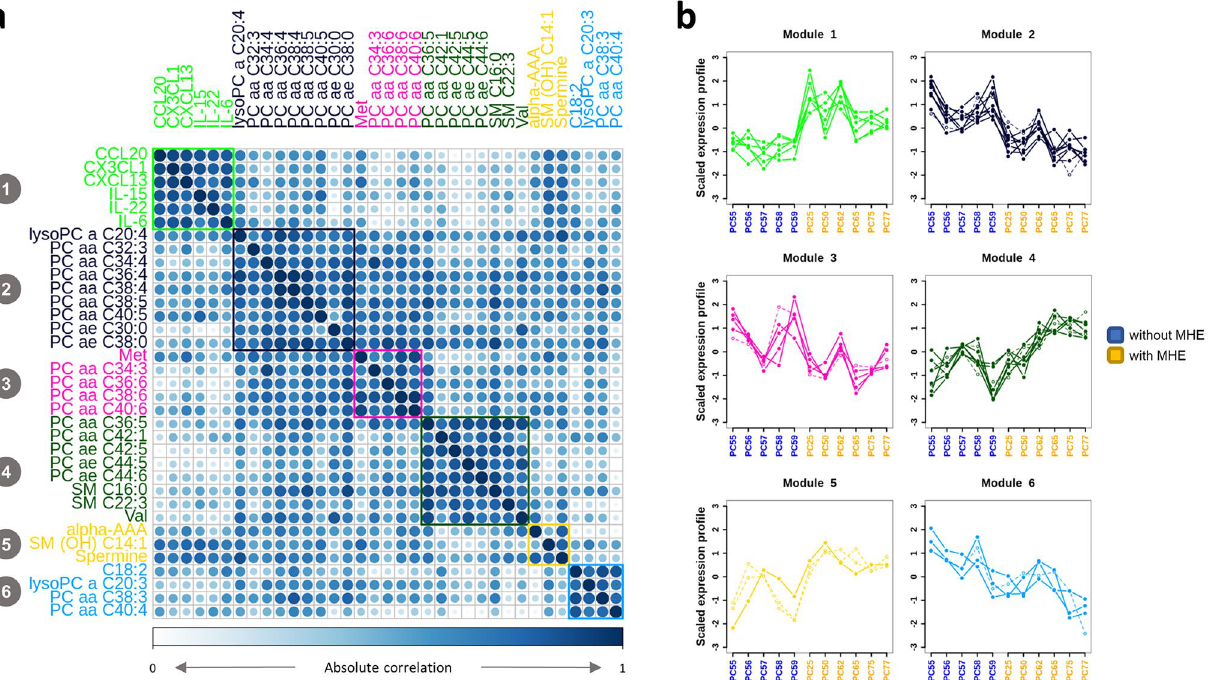
Figure 3. Metabolic and cytokines signature present in MHE patients. ( a ) Absolute correlation plot and clustering analysis of extracellular features. ( b ) Profiles of scaled compound levels across patients indicate the ability to distinguish between the groups of patients with (yellow) and without (blue) MHE. Dashed lines represent compounds with negative correlations with the average block profile, which were set to positive for representation